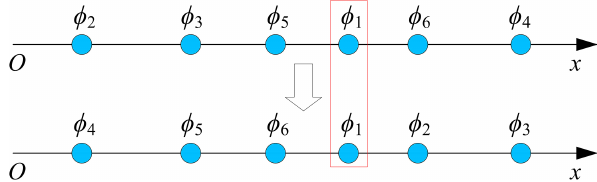
Figure 4. Schematic diagram of the angle repairing